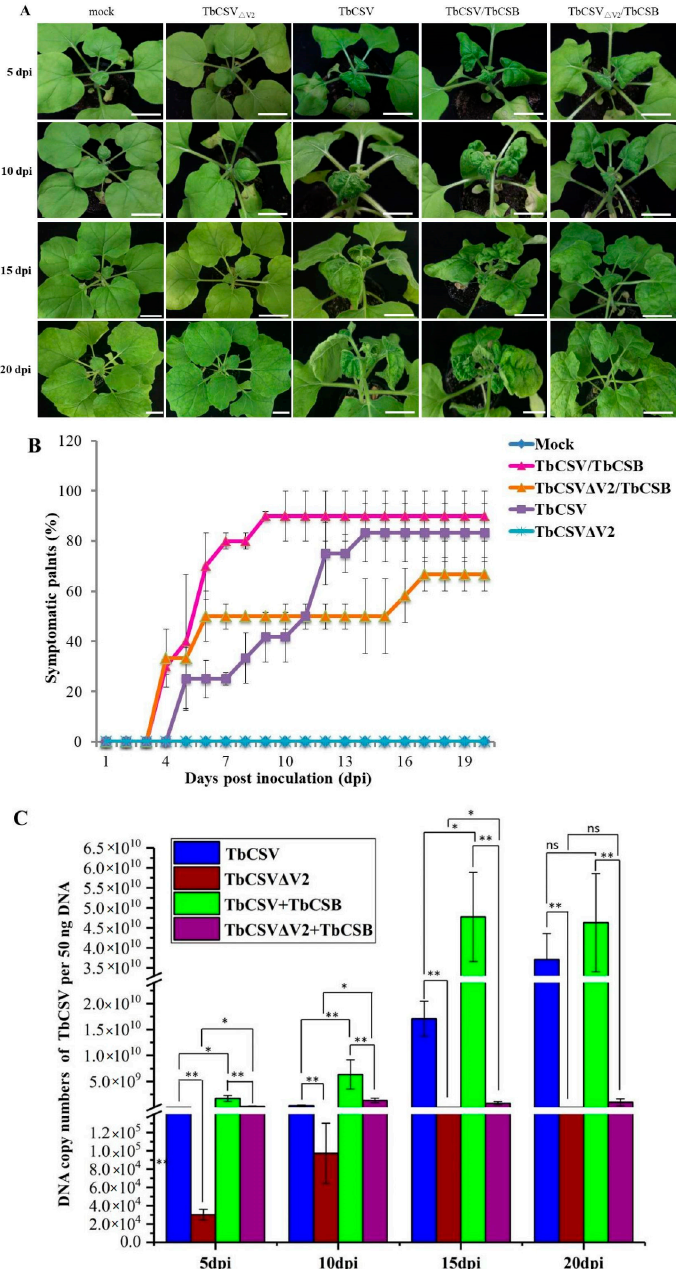
Figure 7. Disease symptoms and virus accumulations in the TbCSV-, TbCSV ∆ V2 -, TbCSV/TbCSB- or TbCSV ∆ V2 /TbCSB- infected N. benthamiana plants. ( A ) Symptoms induced by TbCSV-, TbCSV ∆ V2 -, TbCSV/TbCSB- or TbCSV ∆ V2 /TbCSB inoculations at 5, 10, 15 and 20 days postinoculation (dpi). Buffer inoculation (mock) served as a negative control. Scale bar, 3 cm. ( B ) The incidence of appearance of abnormal phenotypes on the upper leaves at different time points. ( C ) Accumulation of TbCSV DNA in systemically infected leaves of TbCSV-, TbCSV ∆ V2 -, TbCSV/TbCSB- or TbCSV ∆ V2 /TbCSB-inoculated N. benthamiana plants at different time points. Quantitative PCR analyses of TbCSV copy numbers in systemically infected leaves at 5, 10, 15 and 20 dpi. The experiments were conducted three times independently, and at least three technical replicates were used each time. Error bars represented the means ± SE. Significant differences were indicated using Student’s t test: ** indicates p < 0.01, * indicates p < 0.05, “ns” indicates no significant difference. N. benthamiana 25S ribosomal RNA was used as the internal